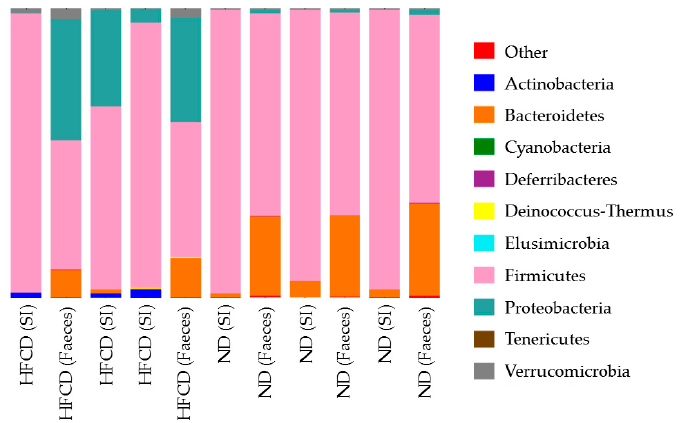
Figure 3. Description of proportional values of indicated phyla of microbiota from each sample. Comparison of microbiota composition in small intestines and feces in stroke-prone spontaneously hypertensive-5 (SHRSP5) rats fed normal diet (ND) or high-fat- and high-cholesterol-containing diet (HFCD). SI, small intestine.